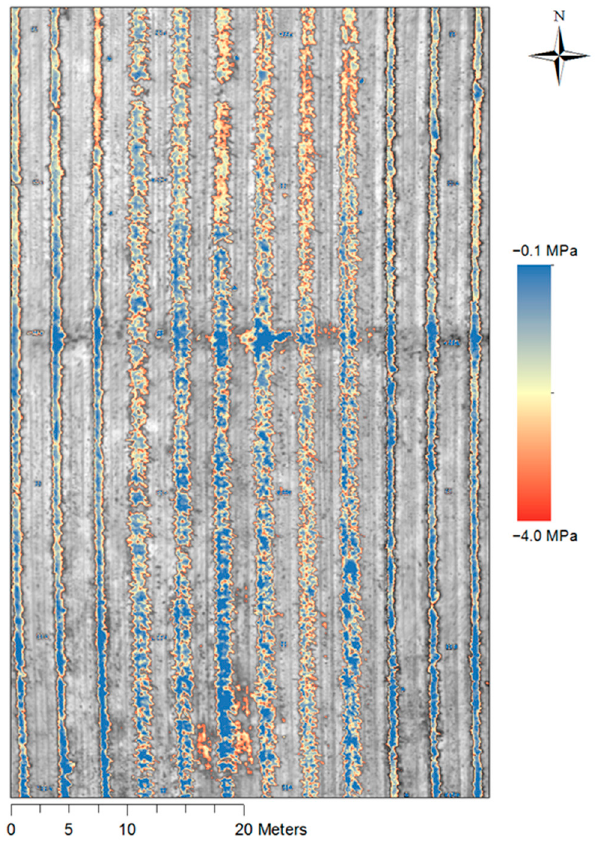
Figure 9. Adaptive stem water potential map ( ψ stem ; Figure 9 . Adaptive stem water potential map ( ψ stem ; MPa).